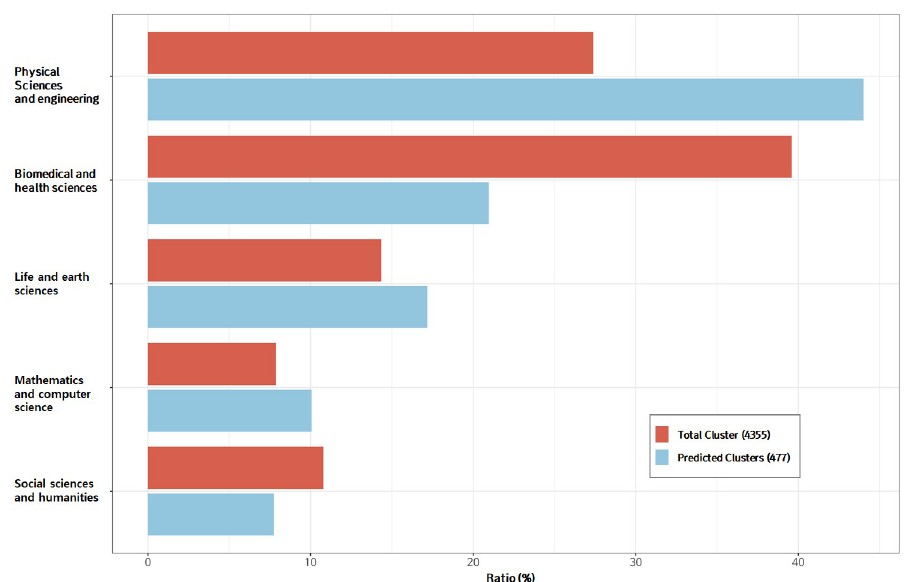
Fig 9. Five fields’ technology clusters: Ratio of number of field’s clusters to total clusters (red color); Ratio of number of field’s clusters to clusters predicted to have high growth potential (blue color).